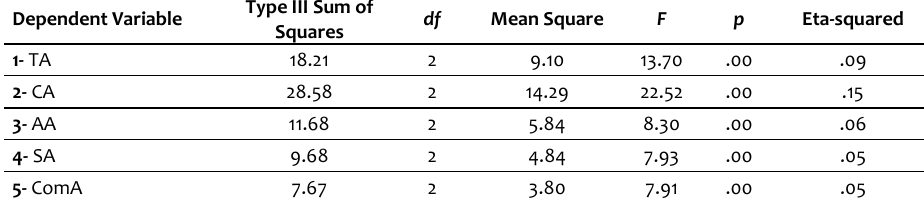
Table 4. Differences in MARS-SV Sub-Scales regarding Preferred Strategy of Coping with